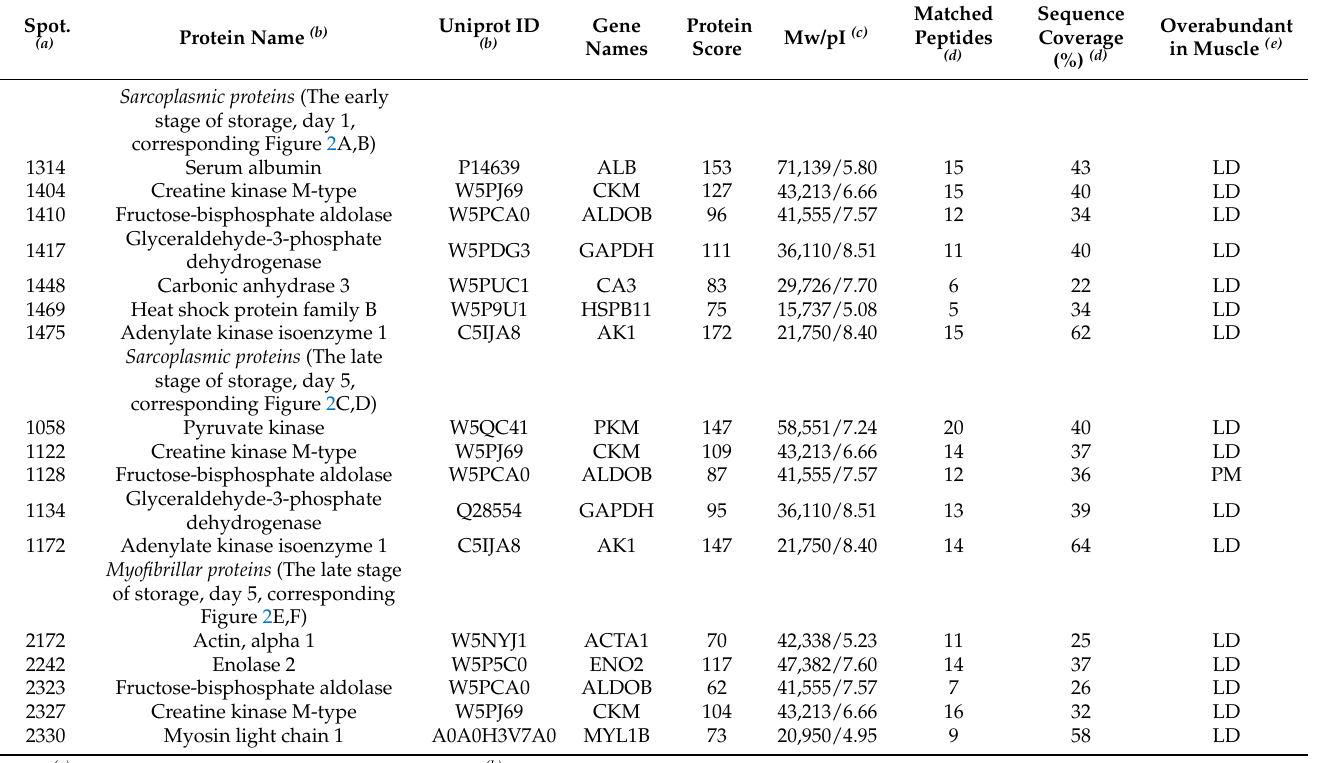
Table 2. Differentially abundant proteins in ovine M. longissimus lumborum (LL) and M. psoas major (PM) muscles at day 1 or day 5 postmortem storage (4 ◦